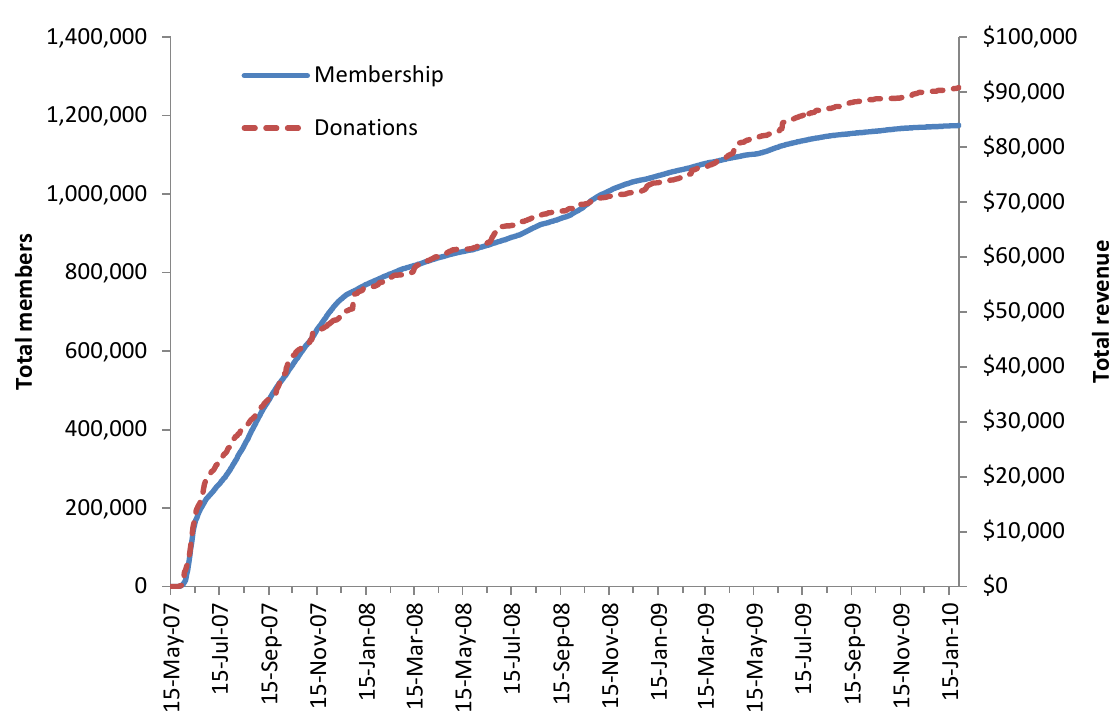
Figure 1: Development of an online social movement. In terms of both members and donations, the Save Darfur Cause experienced a period of rapid growth in the first month after its inception (May 15 to June 15, 2007). Rates of increase began slowing as early as the end of 2007 and had largely plateaued by the end of the data collection period (January 27,